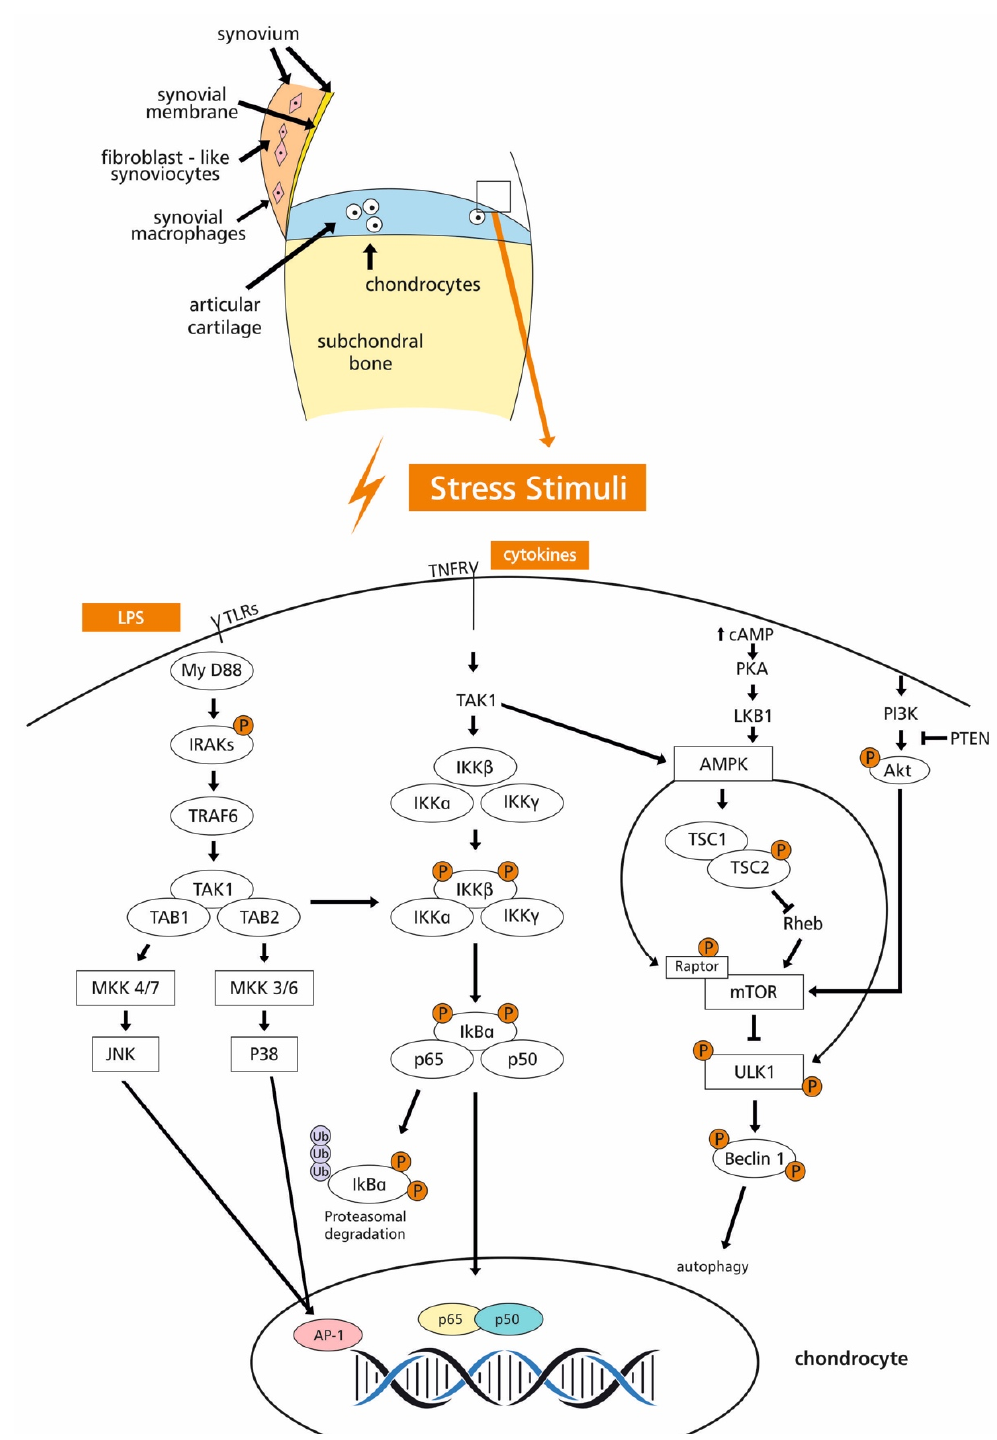
Figure 1. Some signal transduction pathways and their crosstalk in OA modulated by phenolic compounds comprising potent therapeutic targets. Pathways presented from left to right: TLR4 myD88 pathway (IRAKs: Interleukin-1 receptor- associated kinases, TRAF: TNFR-associated factor, TAK1: TGF- β -activated kinase 1, TAB: TAK1-binding proteins, MKK: mitogen-activated protein kinase kinase, JNK: c-Jun N-terminal kinase), canonical NF- κ B pathway (TNFR: Tumor necrosis factor receptor, IKK: I κ B kinase, I κ B: NF-Kb protein), AMPK autophagy pathway (cAMP: Cyclic adenosine monophos- phate, PKA: Protein kinase A, LKB1: Liver kinase B1, AMPK: AMP-activated protein kinase, TSC: Tuberous sclerosis complex, mTOR: Mammalian target of rapamycin, ULK1: Mammalian homolog of yeast Atg1), PI3K/Akt/mTOR pathway (PI3K: Phosphatidylinositol 3-kinase, Akt or PKB: Protein kinase B, PTEN: Phosphatase and tensin homolog deleted on chromosome